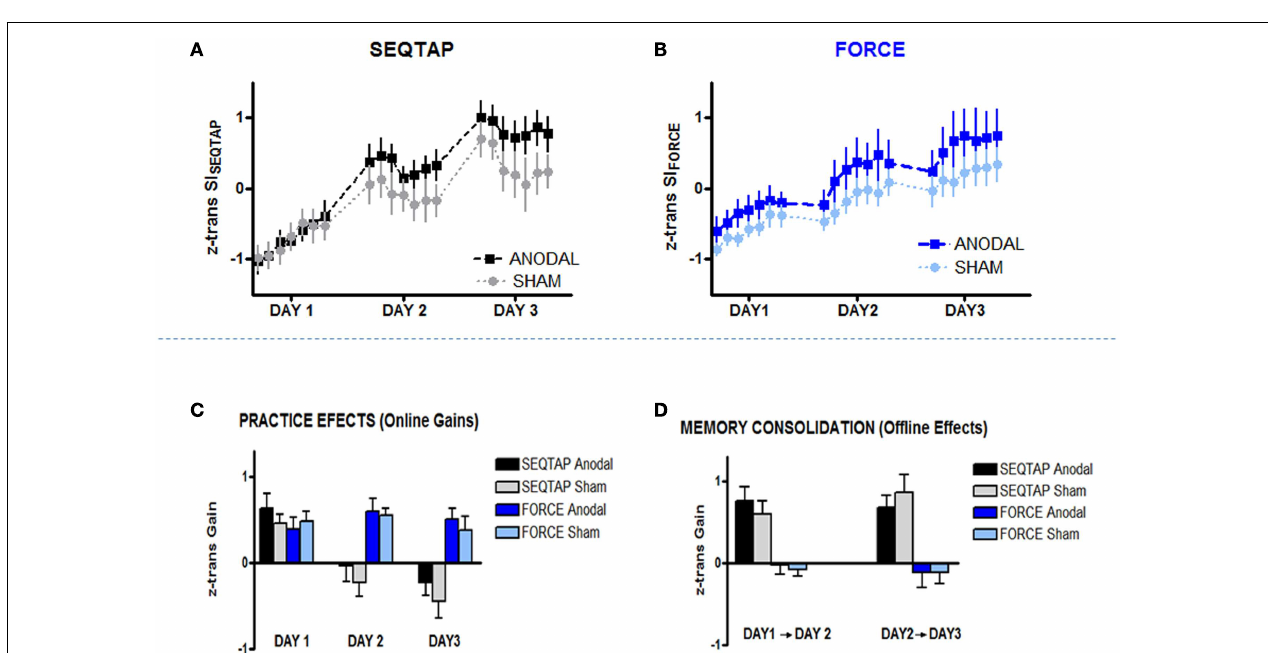
we used the same procedure, with the only difference that the average of the three first and the three last trials was used. (D) Offline effects in the SEQTAP and FORCE data: anodal-tDCS (black and blue bars respectively) compared with the sham-tDCS (gray and turquoise bars respectively). Offline gains in the FORCE task were quantified by subtracting the last trial of 1day from the first trial of the subsequent day.The same procedure was used for the SEQTAP task, with the only difference that the average of the three first and the last three trials was used.Vertical bars indicate standard